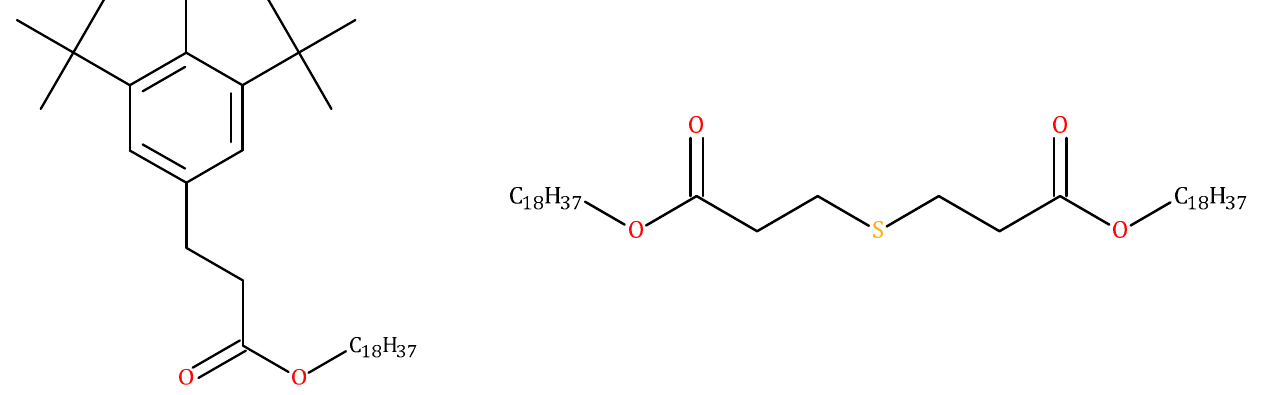
Figure 1. Chemical formulae of Irganox 1076, on the left, and of Irganox PS802, on the right. Samples were furnished by Nexans France in the form of tapes about 500 µ m thick.